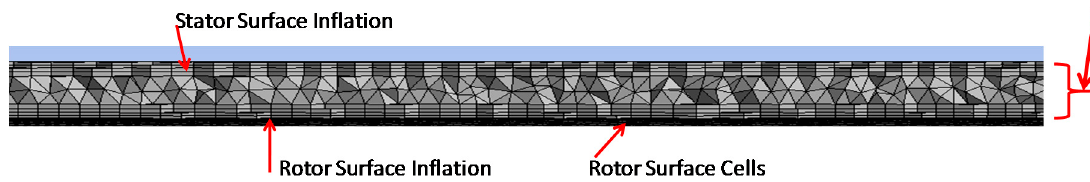
Figure 12. CFD numerical grid prism inflation layers in narrow gap region.